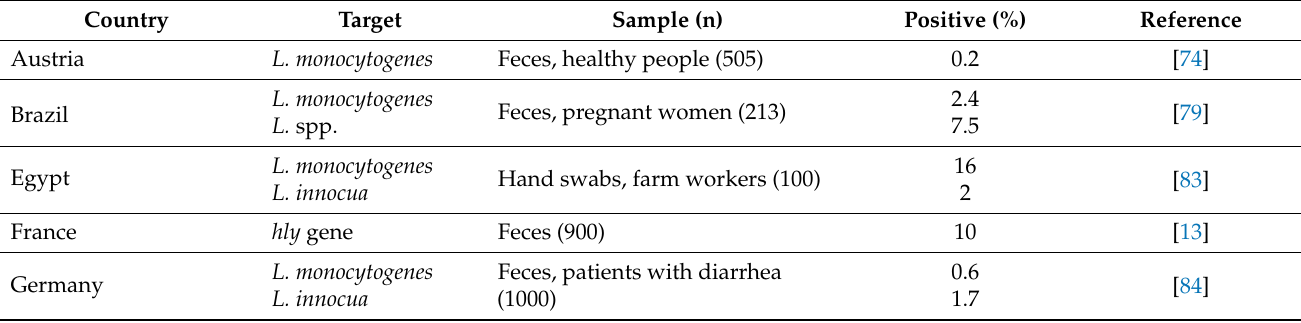
Table 3. Humans as carriers of Listeria